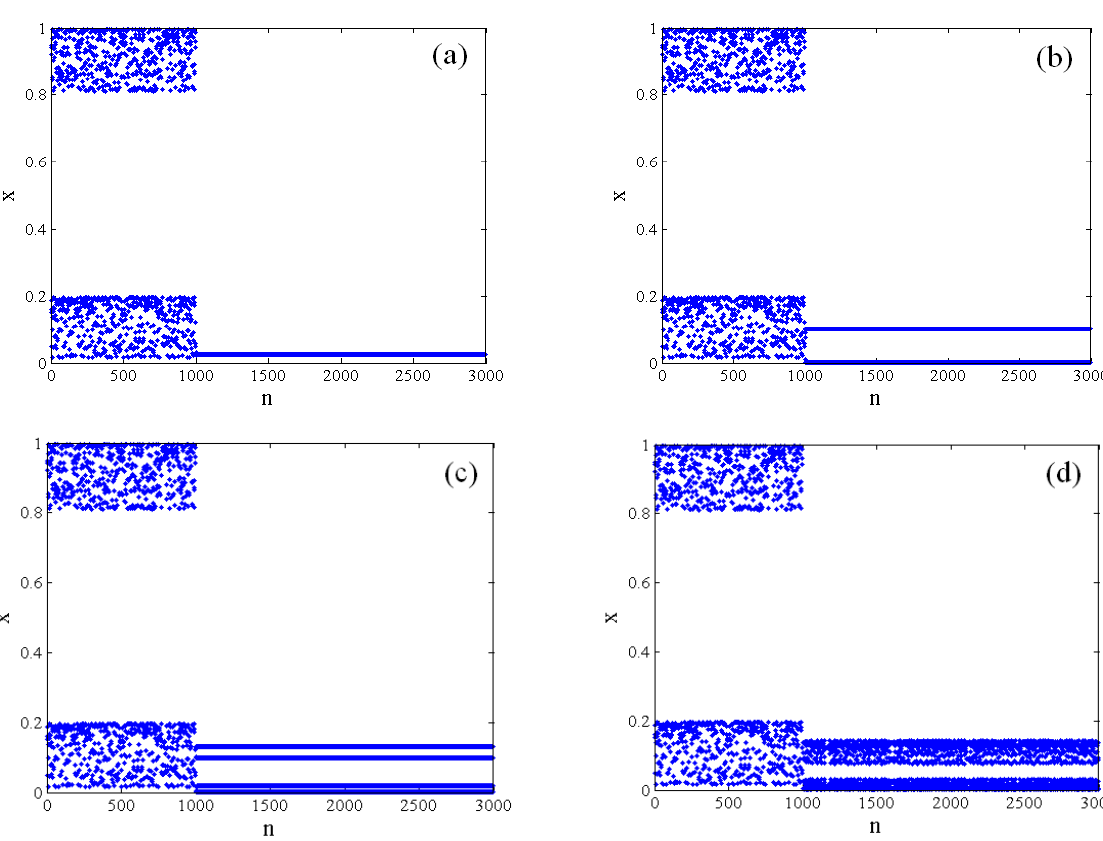
Figure 11. Chaotic controls. ( a ) Chaotic control with k = 0.2; ( b ) chaotic control with k = 0.5; ( c ) chaotic control with k = 0.65; ( d ) chaotic control with k = 0.70.